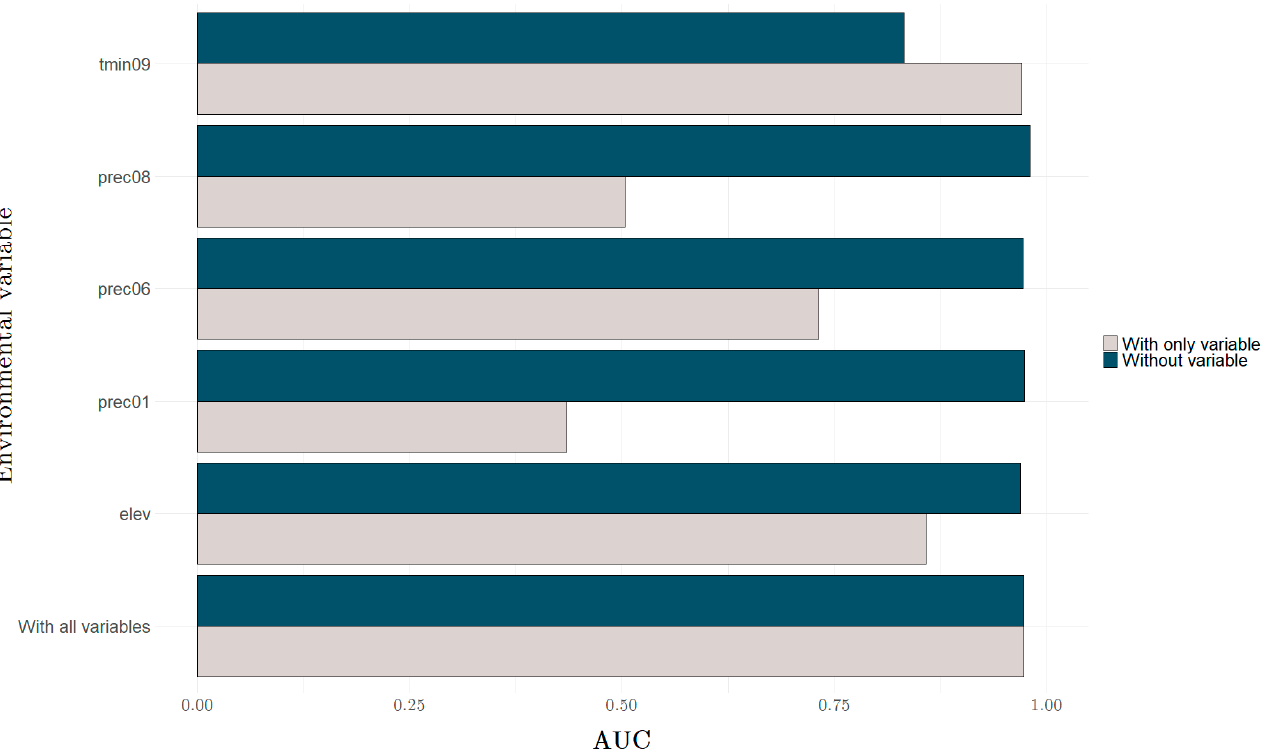
Figure 4. The jackknife test of variable importance. The grey colour indicates using a variable in isolation, and the blue colour specifies the modelling without the selected variable. The higher the score for the first (with only variable) and the lower for the second (without variable), the more critical the selected environmental variable is for the model (AUC—average area under the curve).